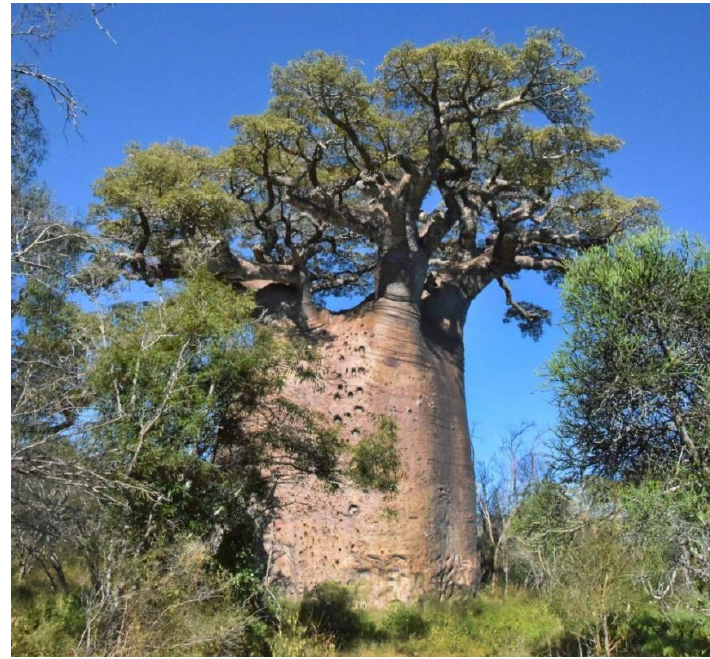
Figure 2. General view of the A 257 baobab taken from the northwest.